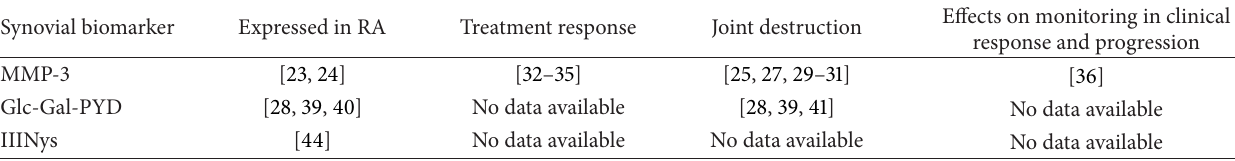
Table 1: Synovium biomarkers and their interests in RA management.